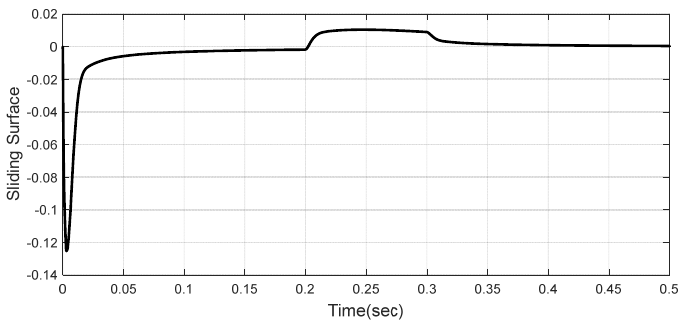
Figure 34. Sliding surface in the presence of measurement noise.